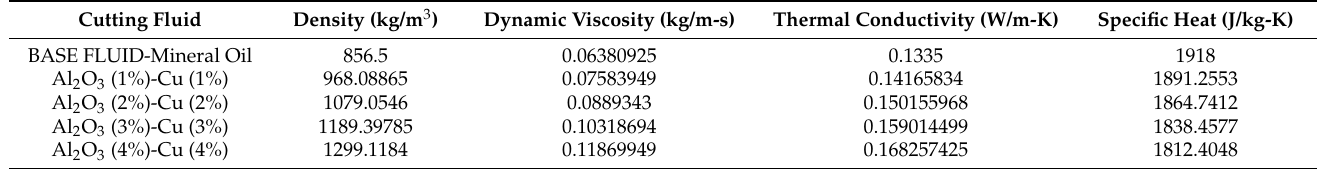
Table 3. Thermophysical and mechanical properties of mineral oil dispersed with Al 2 O 3 -Cu.